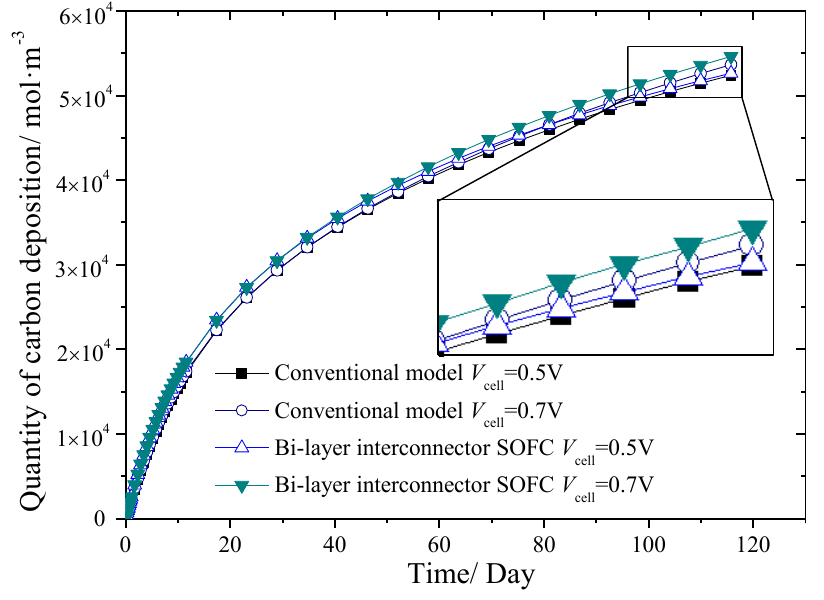
Figure 6. Quantity of carbon deposition for SOFC models with different interconnectors.